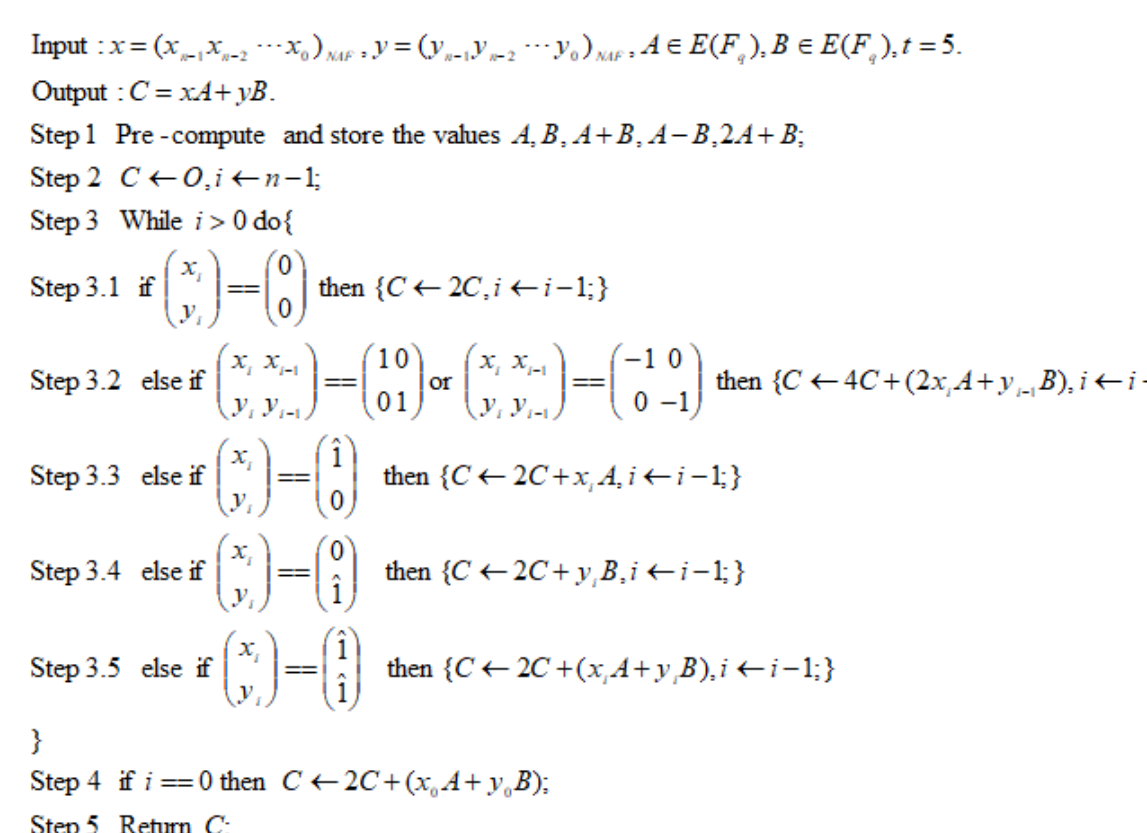
Figure 3. Algorithm The 5-register algorithm using the non-adjacent form (NAF) Figure 3. The 5-register algorithm using the non-adjacent form (NAF) representation.